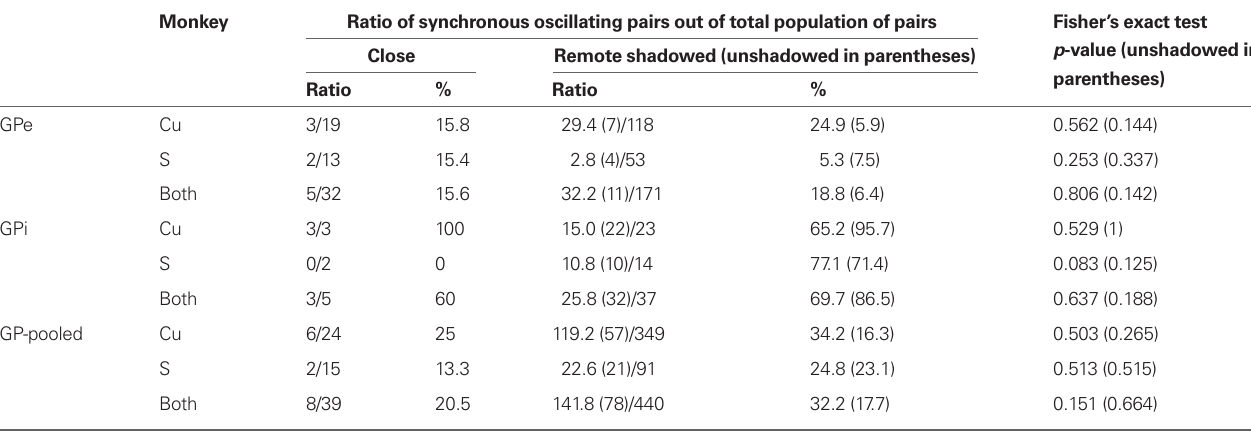
Table 2 | ratio of synchronous oscillating pairs out of total population of pairs: comparison between neighboring and remote cells. Monkey ratio of synchronous oscillating pairs out of total population of pairs Fisher’s exact test